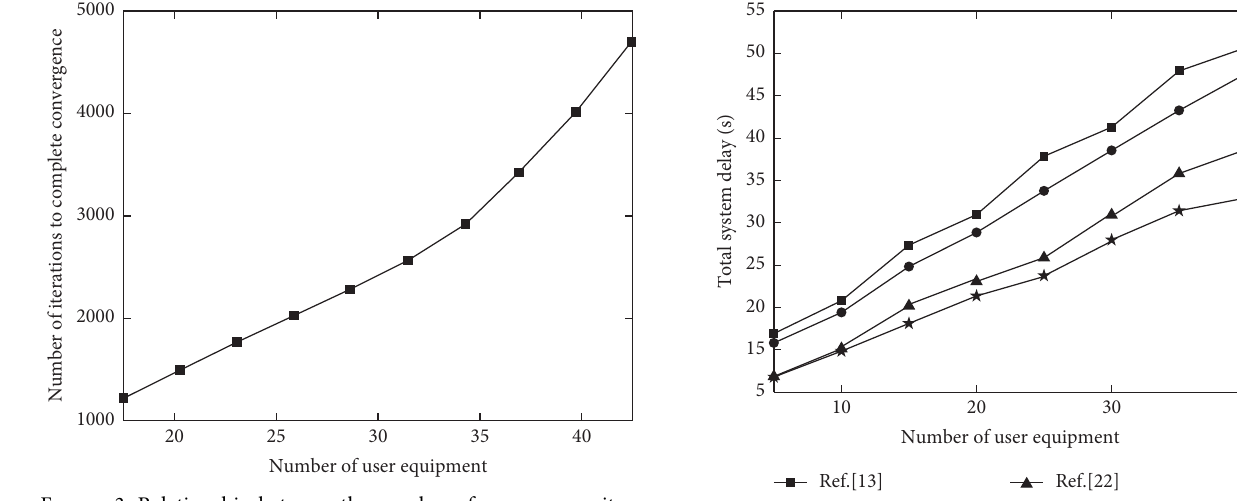
Figure 3: Relationship between the number of convergence iter- ations and the number of system